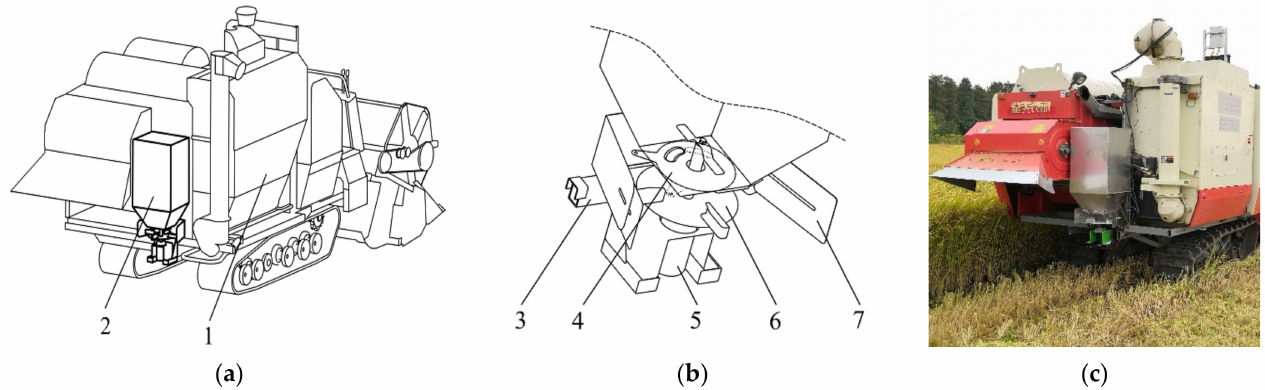
Figure 1. Schematic structure of centrifugal disc spreader on tracked combine harvester. ( a ) Position of centrifugal disc spreader on tracked combine harvester; ( b ) schematic structure of centrifugal disc spreader; ( c ) physical picture of centrifugal disc spreader. (1) Tracked combine harvester, (2) fertilizer box, (3) frame, (4) fertilizer quantity adjustment regulator, (5) DC moto, (6) centrifugal disc, and (7)